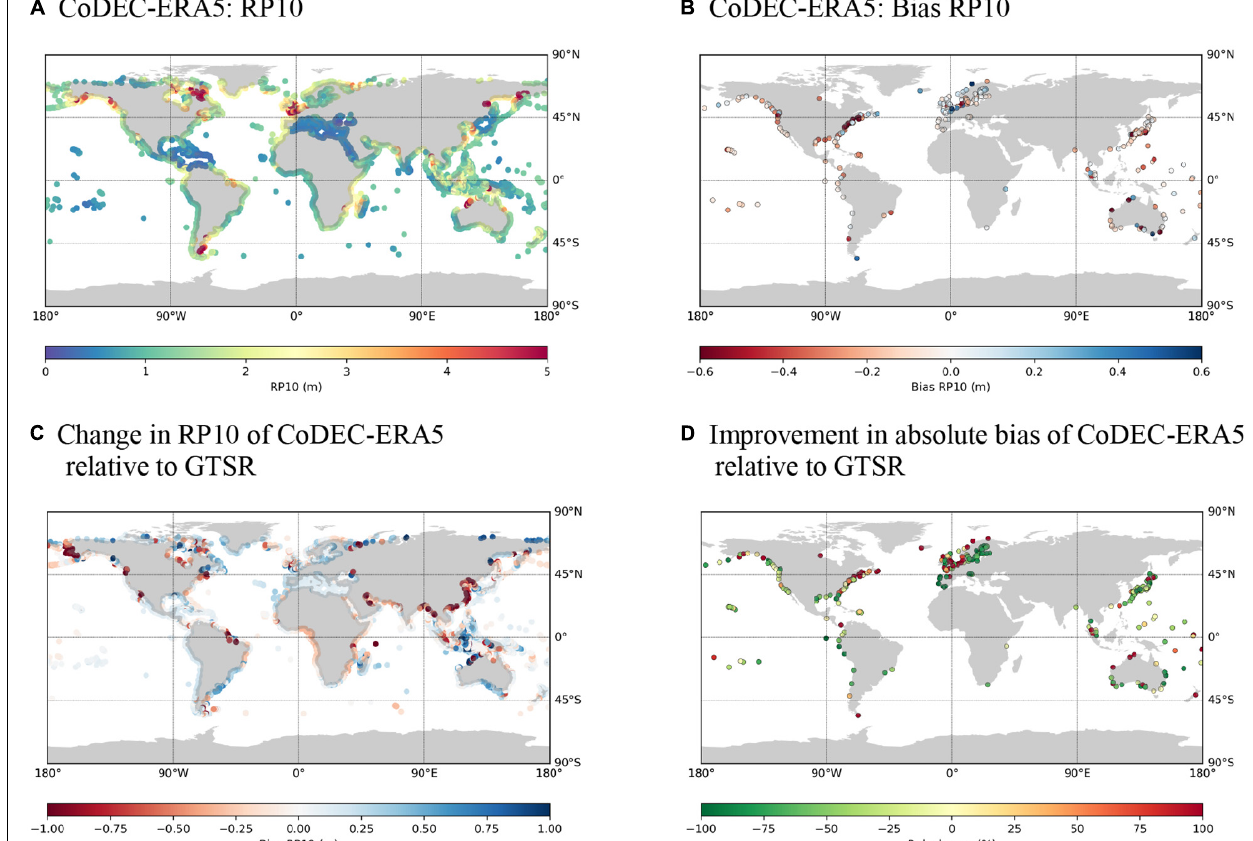
FIGURE 4 | Modeled water levels with (A) 1 in 10-year return periods (RP10) for (A) the CoDEC-ERA5 dataset, as well as (B) the bias of the 1 in 10-year water levels compared against observations from the GESLA dataset, (C) difference between the 1 in 10-year water levels derived from the CoDEC-ERA5 dataset and the GTSR dataset, and (D) Improvement in absolute bias of